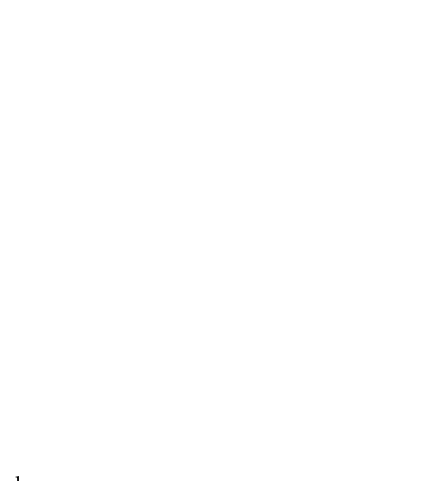
Table 2. Clinical data on DEB-TACE. CB = CalliSpheres ®